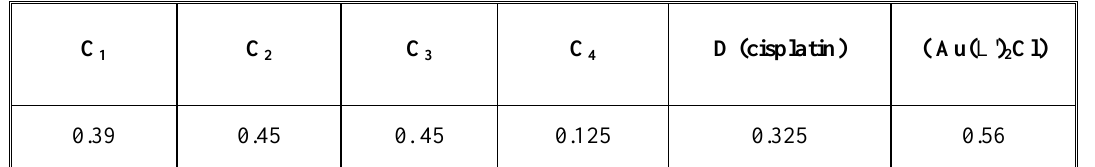
of C – C compared to cisplatin 50 1 4